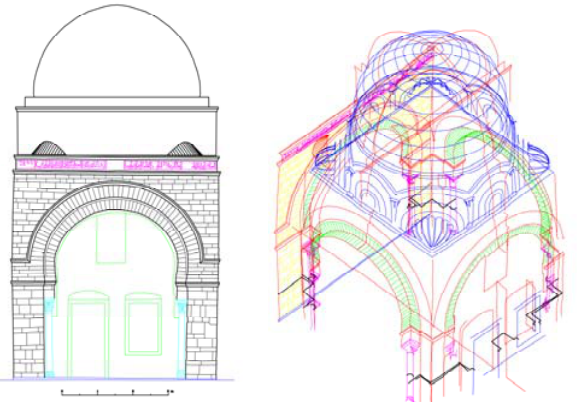
Figure 2. Elevation and 3D model of the